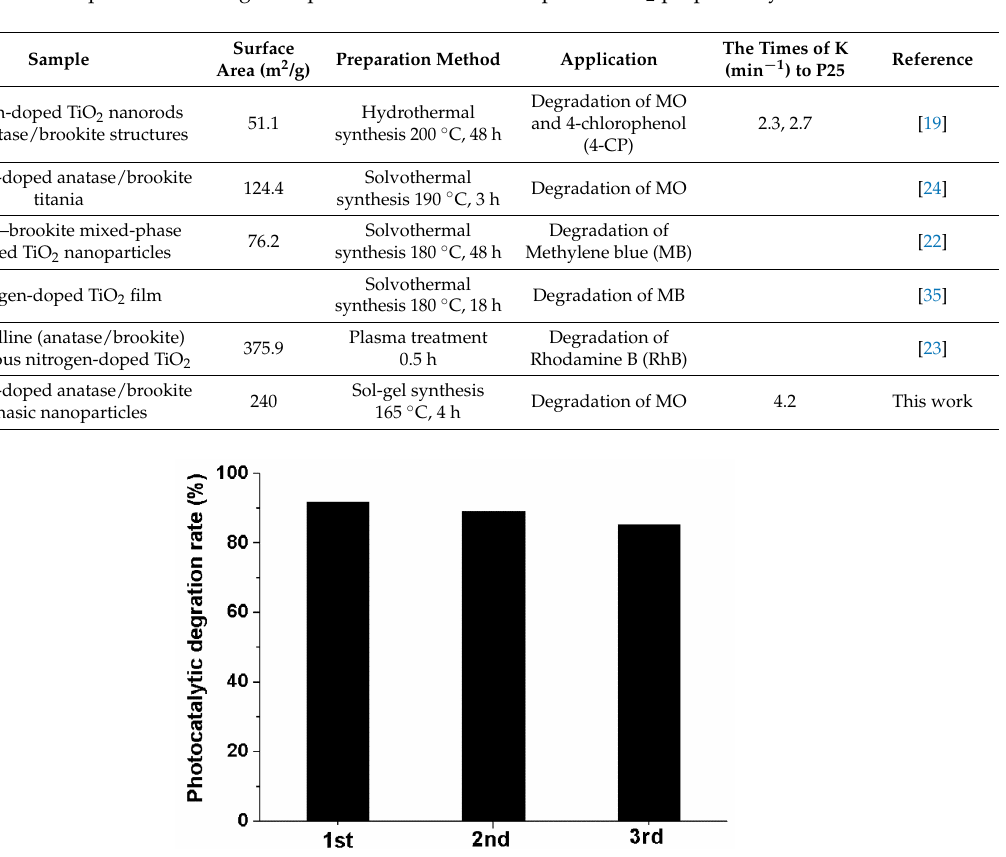
Table 2. Comparison of nitrogen ‐ doped anatase/brookite biphasic TiO 2 prepared by various methods.